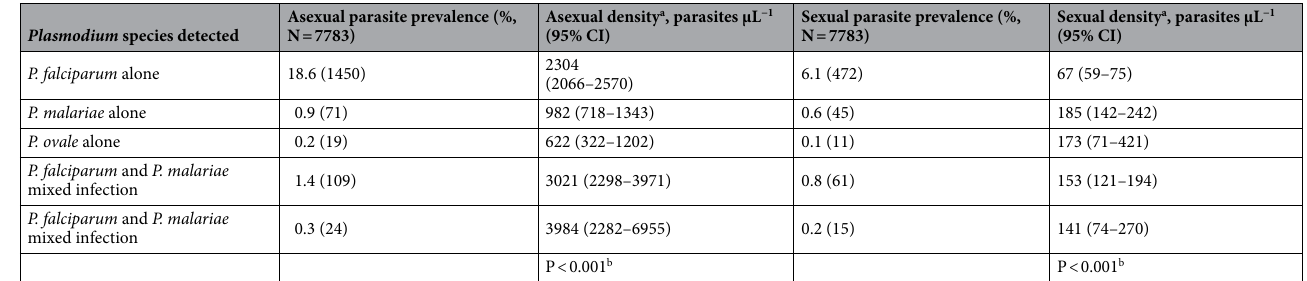
Table 3. Prevalence and density of different Plasmodium species infections in children up to 5 years of age in Nigeria. a Geometric means (with 95% confidence intervals) of parasite densities tabulated. b Kruskal–Wallis tests for comparisons of parasite densities across categories. Slide read data on all individuals are given in Supplementary Table S3.